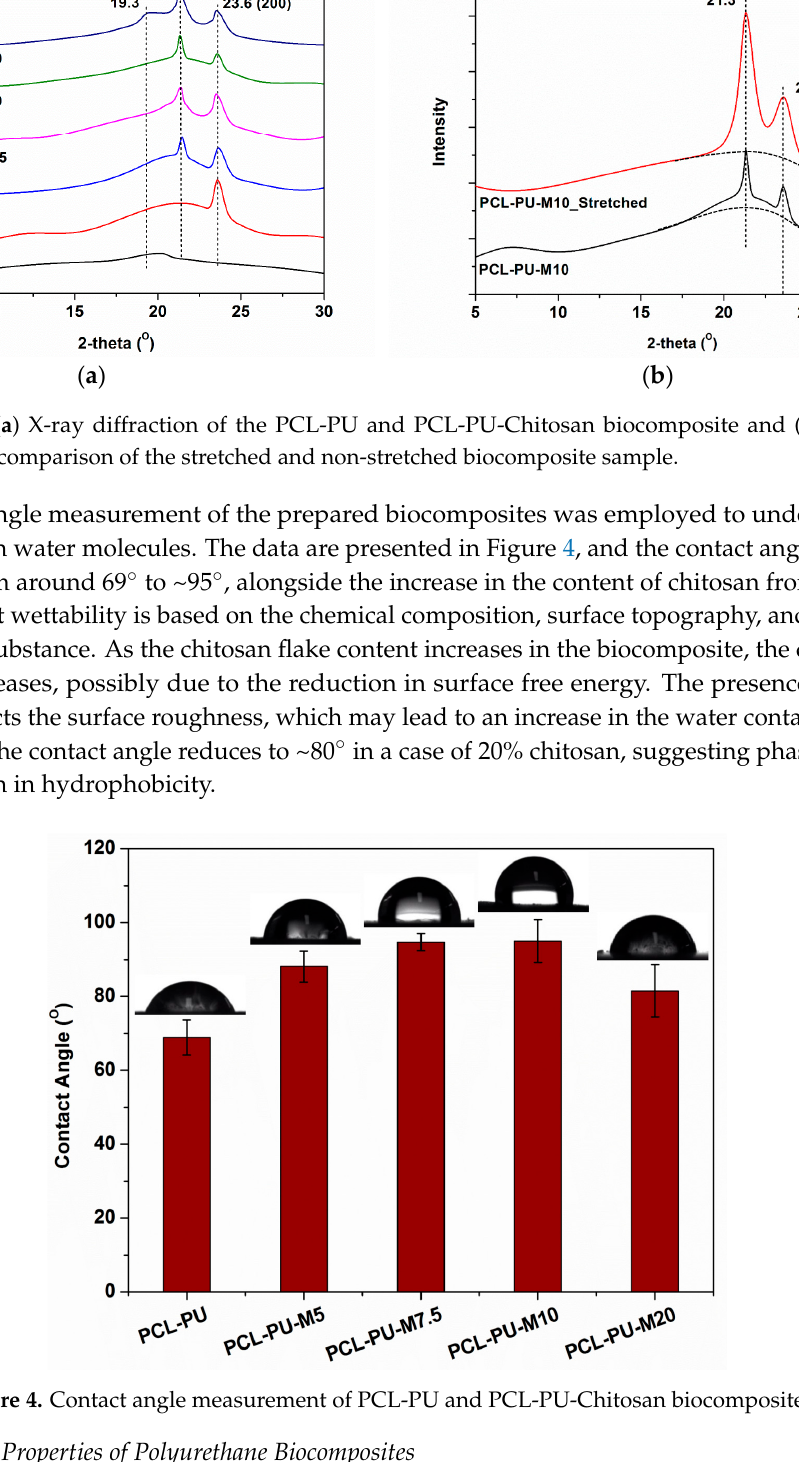
Figure 4. Contact angle measurement of PCL-PU and PCL-PU-Chitosan biocomposites.